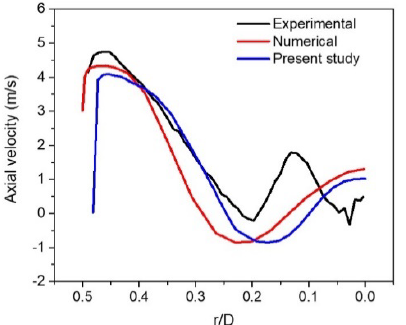
Figure 5. Comparison of the present study and literature data of numerical and experimental results [22]. (The data points were extracted from the reference.) Table 3. Numerical calculation results for design